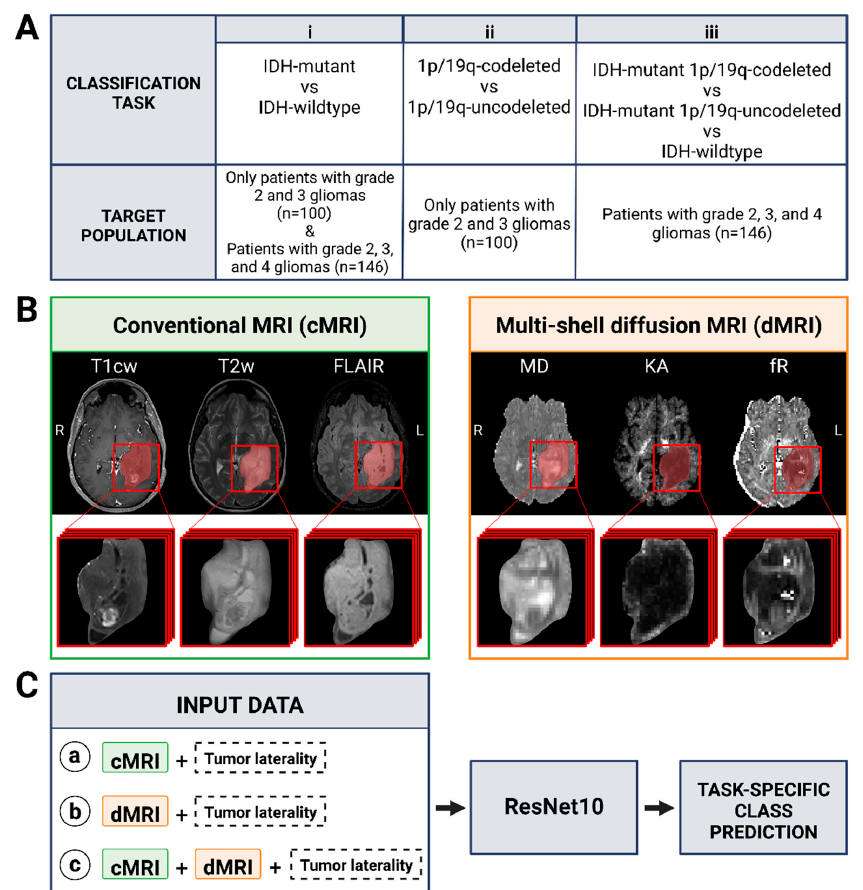
study. ( B ) Representative conventional and diffusion MR images of a 23-year-old female